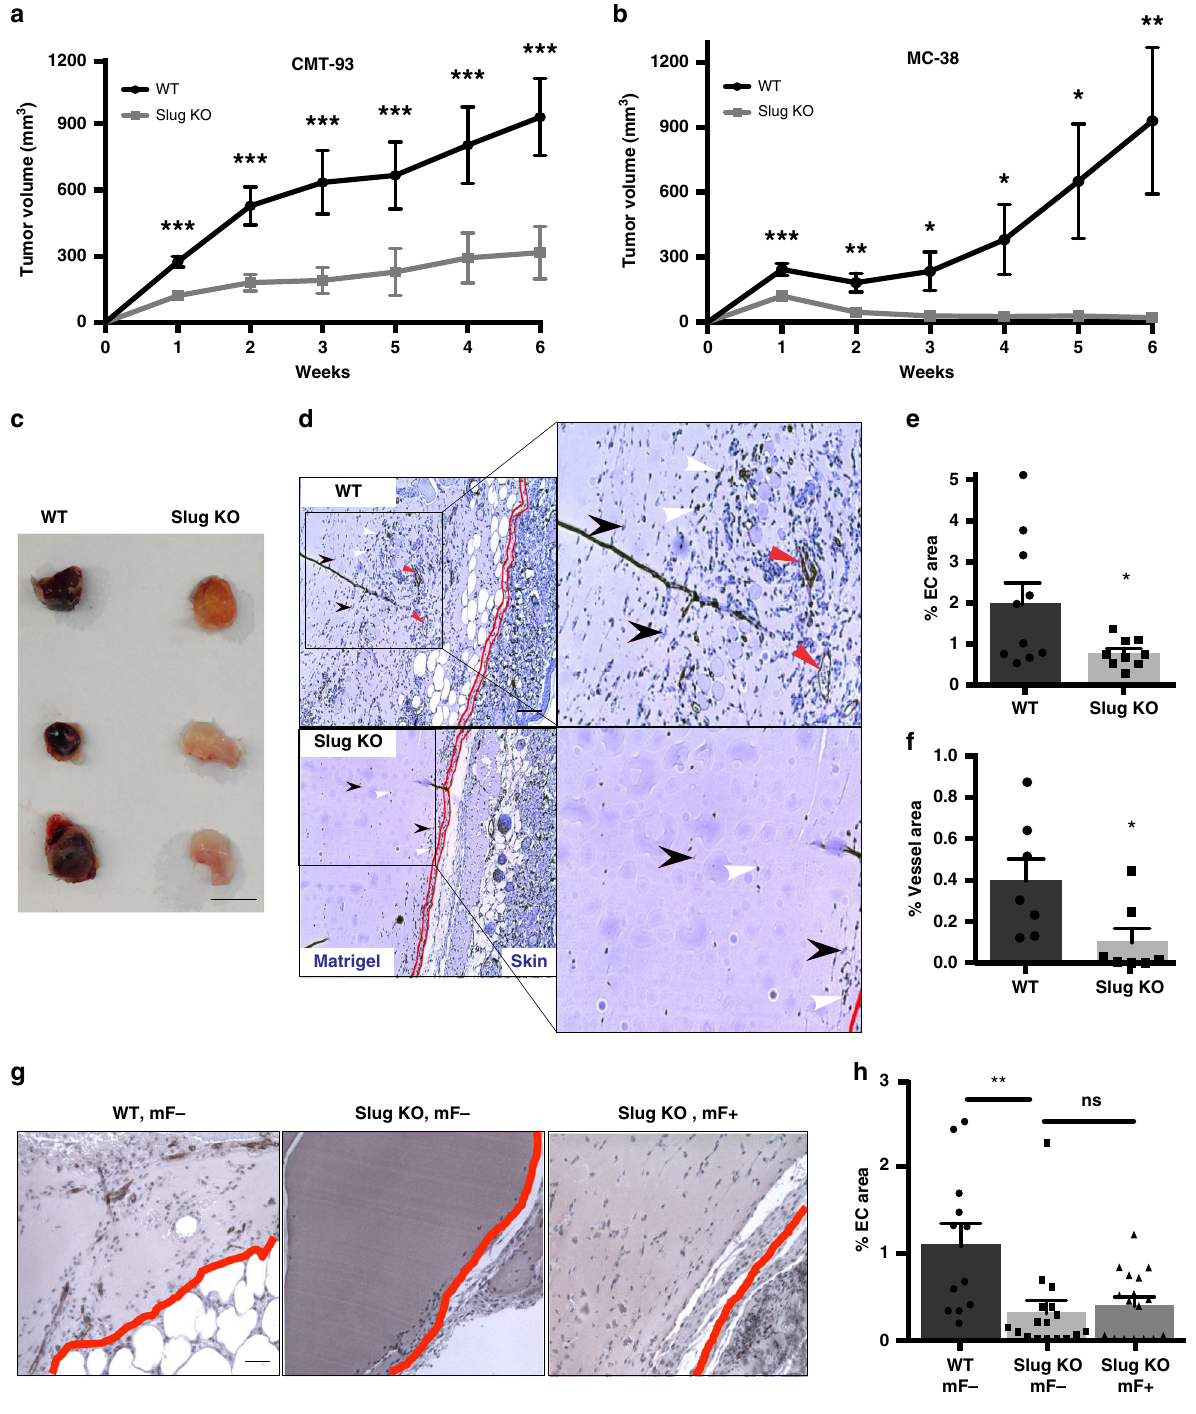
Fig. 1 Slug de fi ciency inhibits tumor growth by reducing tumor angiogenesis. a Growth curve of CMT-93 colorectal tumors in WT ( n = 24) and SlugKO ( n = 27) mice. b Growth curve of MC-38 colon tumors in WT ( n = 11) and SlugKO ( n = 12) mice. c Matrigel plugs harvested from WT and SlugKO mice. Scale bar: 1 cm. d CD31 staining of Matrigel sections reveals reduced EC recruitment (CD31 + EC indicated by white arrow heads), reduced vessel formation (indicated by lack of lumenized vessels, shown by red arrow heads in control), and reduced stromal cellularity (indicated by decreased CD31 − /hematoxylin + cells, shown by black arrow heads) in Matrigel plugs of SlugKO mice. Double red lines indicate border between native mouse skin and Matrigel. Scale bar: 100 µ m. e Average percent CD31 + area in Matrigel sections from WT ( n = 10) and SlugKO ( n = 9) mice. p = 0.036. f Average percent lumenized vessel area in Matrigel sections from WT ( n = 7) and SlugKO ( n = 7) mice. p = 0.037. g CD31 staining of Matrigel sections indicates that the addition of WT mF cannot rescue the impaired EC recruitment in SlugKO mice. Red line indicates border between native mouse skin and Matrigel. Scale bar: 100 µ m. h Average percent CD31 + area in Matrigel sections from WT ( n = 12) and SlugKO (mF − : n = 17, mF + : n = 17) mice. p = 0.004. Data represent mean ± SEM. Two- tailed unpaired equal-variance t test. * p <0.05, ** p < 0.01, *** p < 0.005. Source data are provided as a Source Data fi